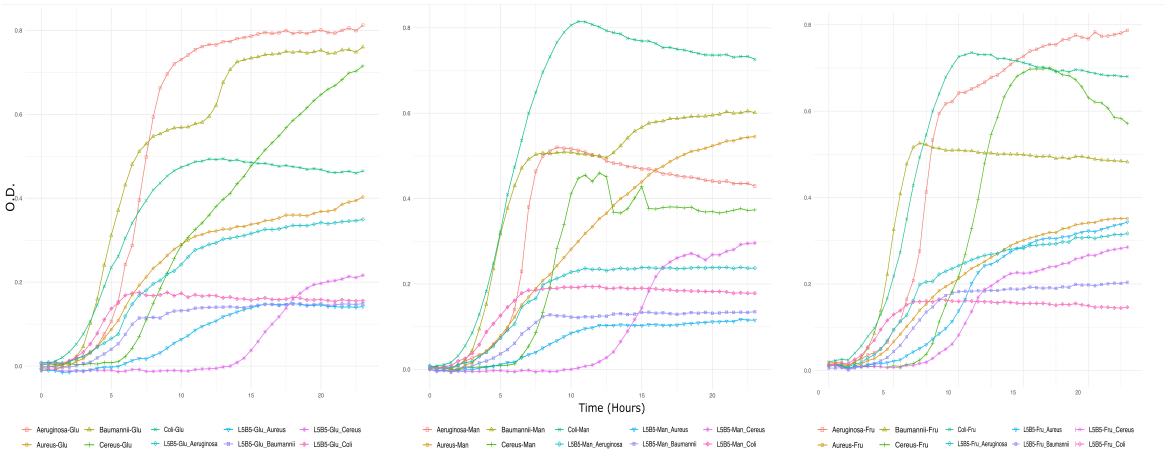
Figure 2. Second assay of inhibition of pathogens by Pseudomona s sp., strain L5B5, filtrate using alternative source carbons, NB-Glucose ( left ), NB-Mannose ( center ) and NB-Fructose ( right ). Positive controls representing the normal growth of pathogens without the filtrates of Pseudomonas sp., strain L5B5 are also displayed in graphics, with the name of the tested species (Aeruginosa, Aureus, Bau- mannii, Cereus and Coli) and the used carbon sources (Glu-Man-Fru). Inhibition test: Crude filtrates of strain L5B5 culture with NB-Glucose-bacteria are represented as L5B5-Glu-(Aeruginosa, Aureus, Baumannii, Cereus or Coli) ( left ), NB-Mannose-bacteria as L5B5-Mn-(Aeruginosa, Aureus, Bauman- nii, Cereus or Coli) ( center ), NB-Fructose-bacteria as L5B5-Fru-(Aeruginosa, Aureus, Baumannii, Cereus or Coli) ( right ).